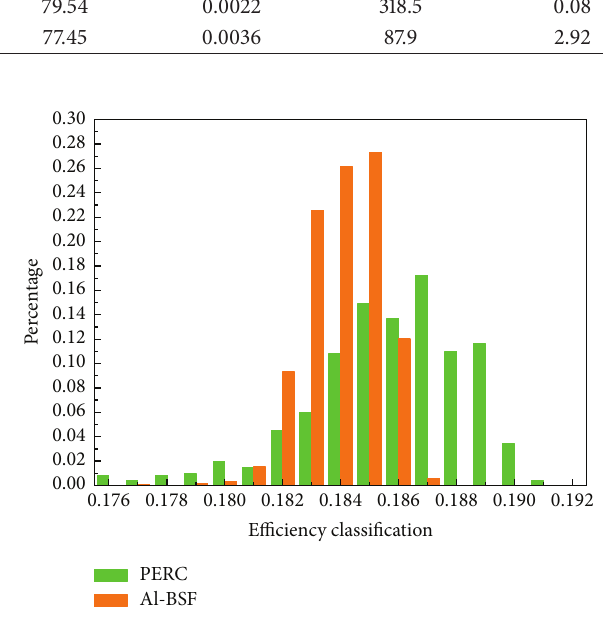
Figure 5: Efficiency distribution of Mc-Si solar cells with Al-BSF and PERC